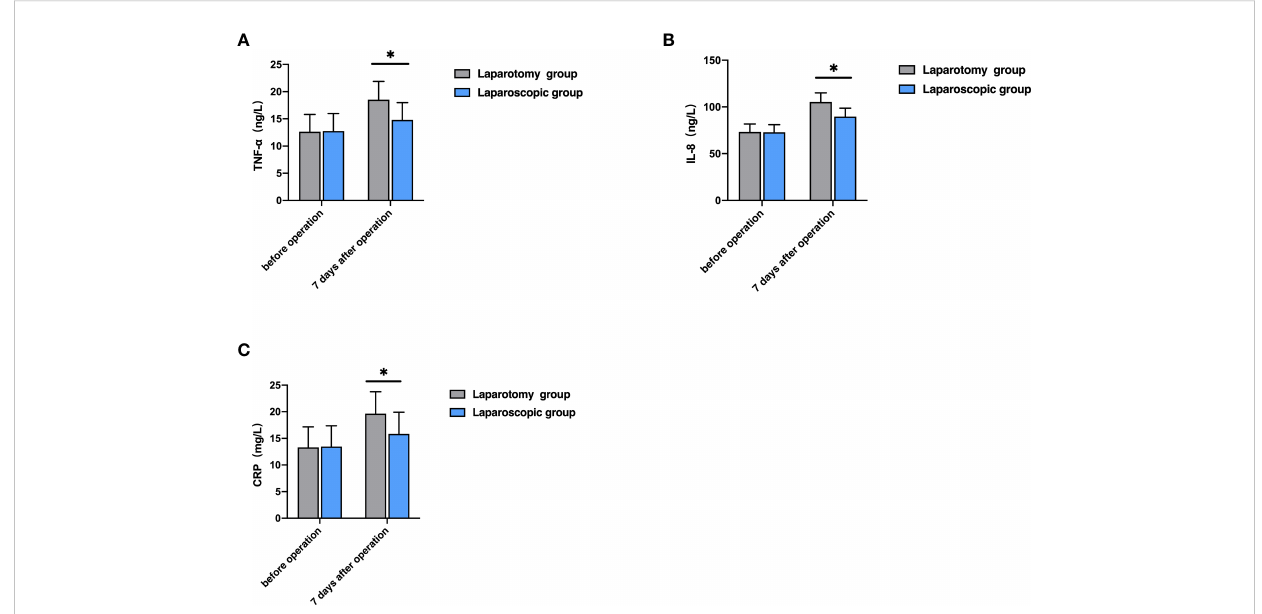
FIGURE 3 Comparison of serum in fl ammatory factors between the two groups. (A) Comparison of TNF- a level; (B) Comparison of IL-8 level; (C) Comparison of CRP level; * P <0.05).